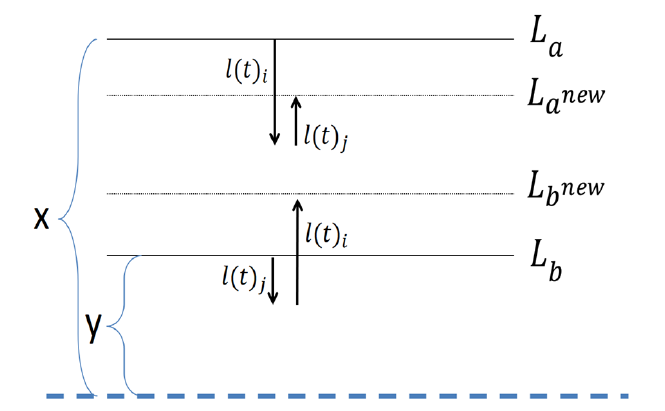
Figure 3. Clusters loads after replacement on the same side with reference to the average.